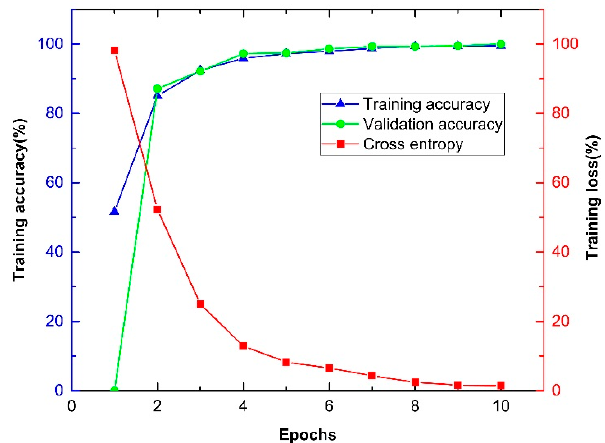
Figure 4. Training process using our network.